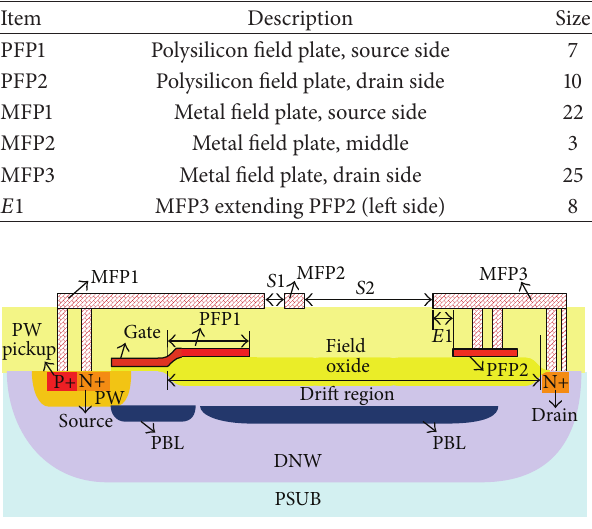
Figure 1: Schematic cross section of high voltage NLDMOS.